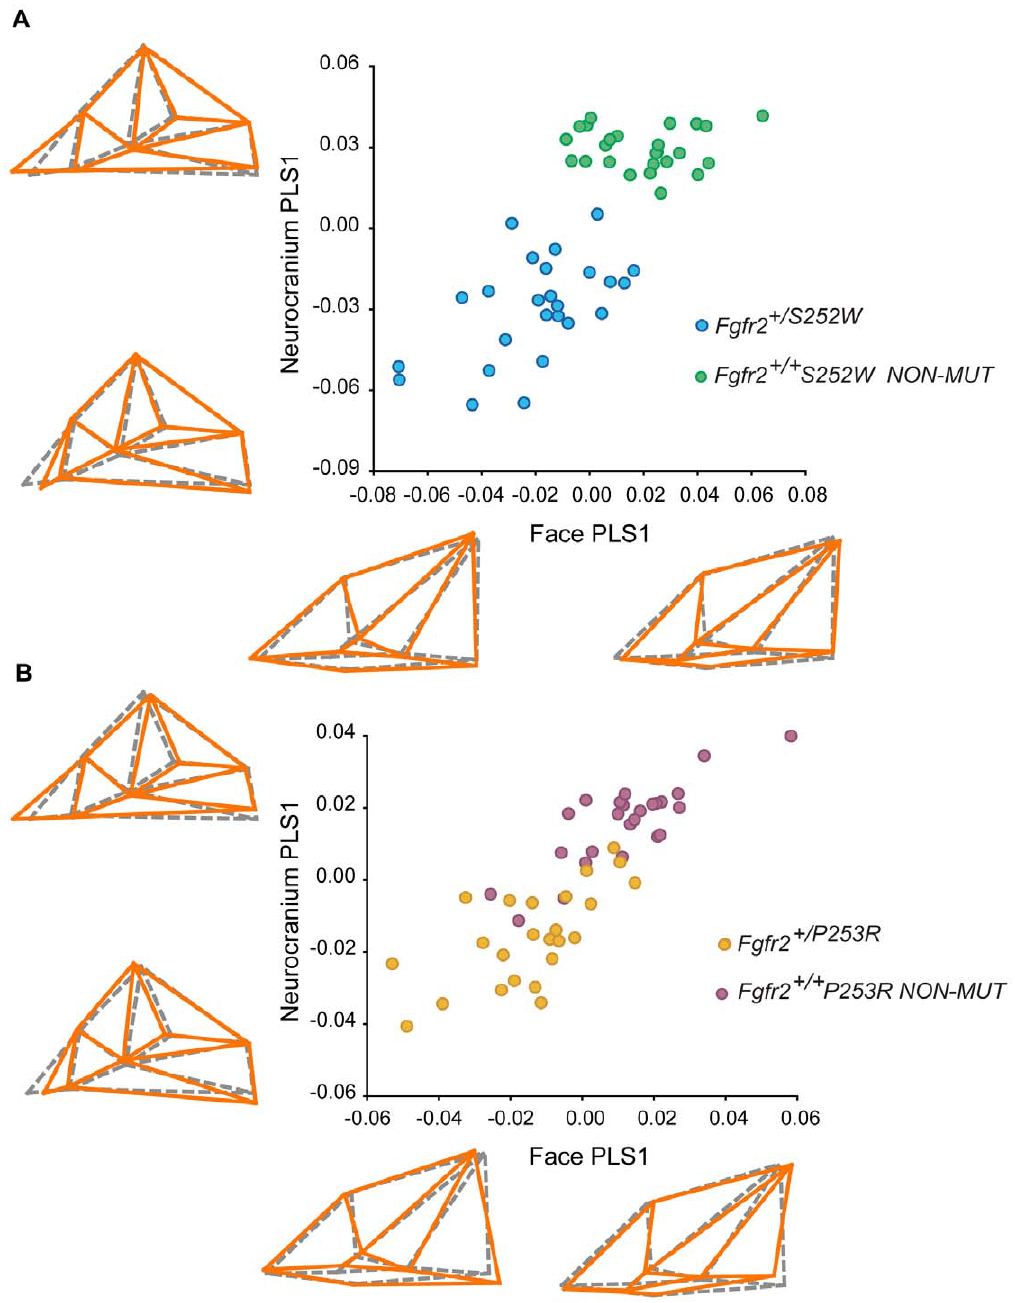
Figure 3. PLS analyses among each Apert syndrome mouse model and their non-mutant littermates after removing allometry. A) Fgfr2 + /S252W and non-mutant littermates; B) Fgfr2 + /P253R and non-mutant littermates. Associated facial and neurocranial shape changes corresponding to the first pair of PLS1 axes show similar skull MI patterns between the two models. Orange wireframes display face and neurocranium shape changes associated with positive and negative values of PLS1 in comparison to mean shape PLS1 values (grey dashed wireframe). For anatomical correspondence see Fig. 1. Note that all landmarks cannot be seen from a single skull view and we chose to display the inferior view of the skull because main shape changes occur in the palate and the anterior aspect of the neurocranium.